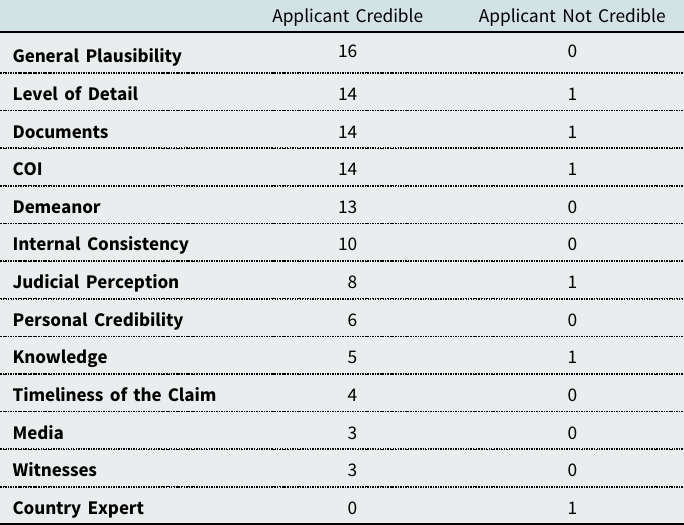
Table 4. Positive Credibility Criteria